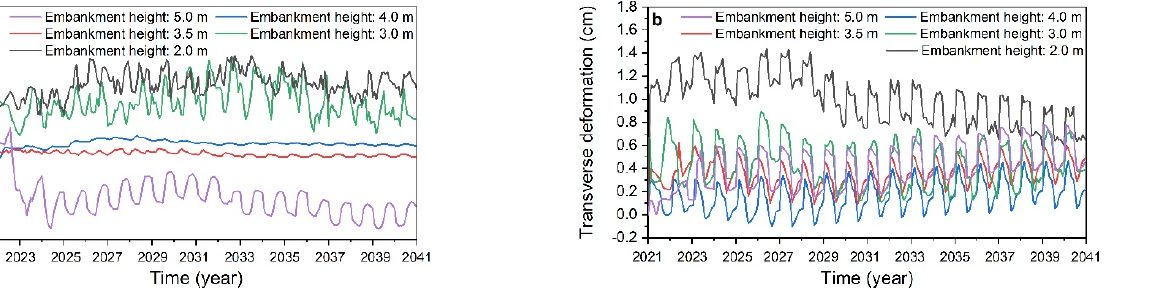
Figure 12. Transverse deformation curves at the road centerlines and shoulders of different struc- tures: ( a ) at the road centerline and ( b ) at the shoulder. The difference in transverse deformation between the shoulder and the road center- line can reflect the change features in longitudinal cracks in the subgrade. When the sub- grade enters the plastic deformation stage, the transverse deformation difference is posi- tively correlated with the width of the longitudinal crack [34].